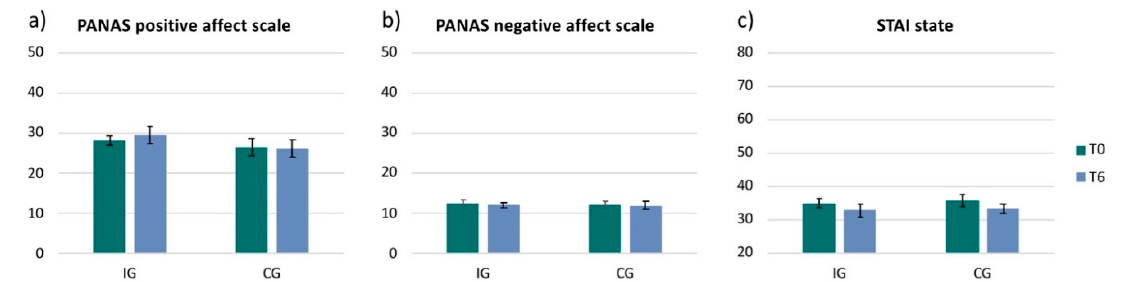
Figure 4. PANAS and STAI. Bar plots show the 2 dimensions of the PANAS (positive and negative) and the STAI state for each group (IG = intervention group and CG = control group) and for each timepoint (T0 and T6): ( a ) PANAS Positive Affect Scale; ( b ) PANAS negative affect scale; ( c ) STAI state.